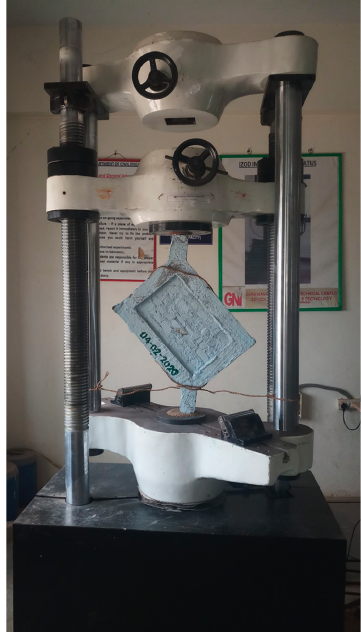
Figure 4: Loading arrangement of the